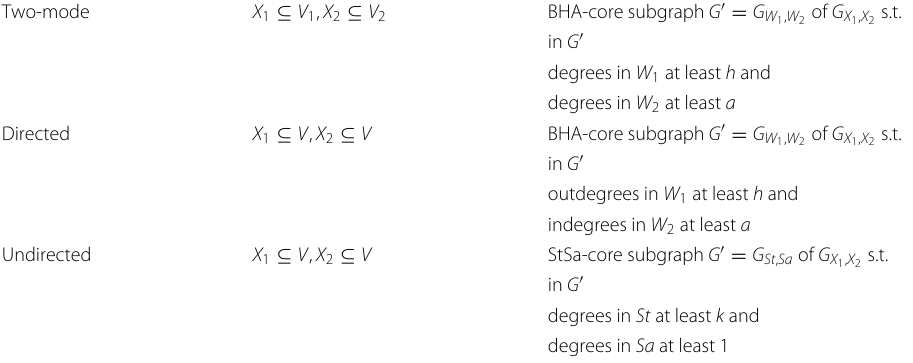
Table 1 Two components core definitions for various kind of networks